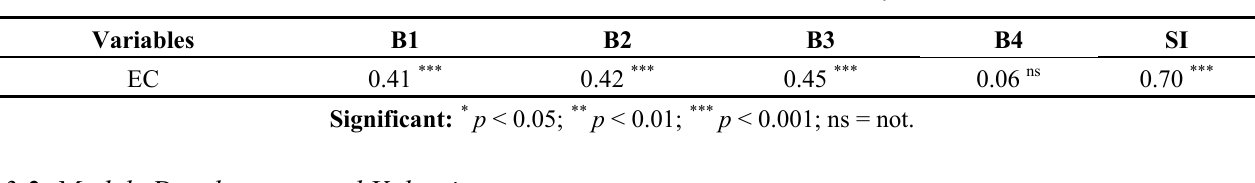
Table 3. Correlation coefficient between EC and remotely sensed data.